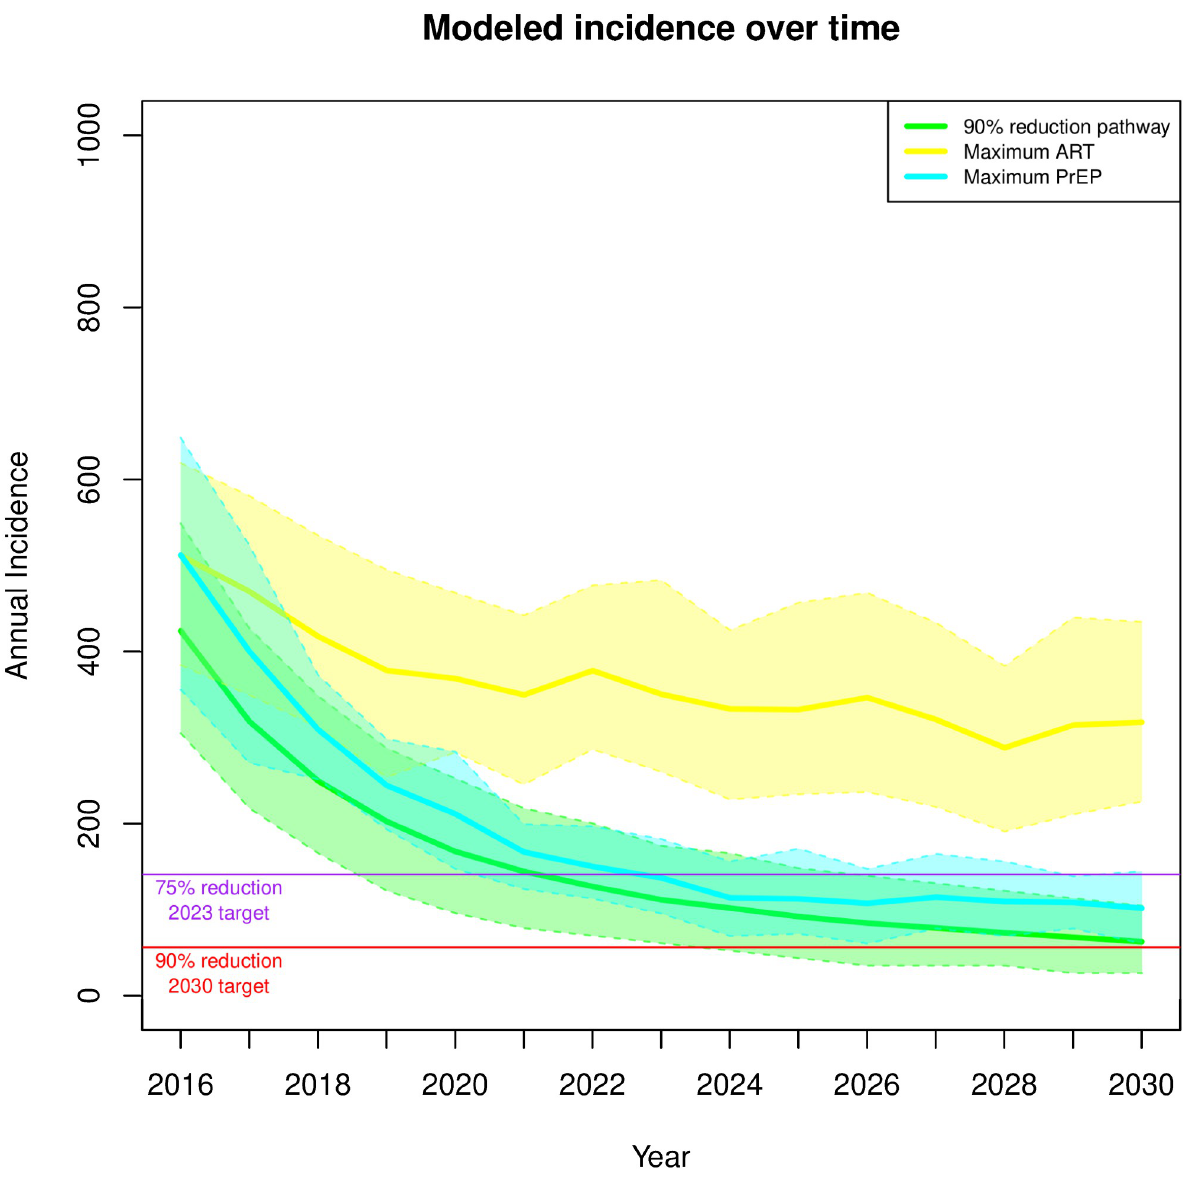
Fig 8. Projected number of incidence cases over time for extreme scenarios: Projected incidence over time for 90% reduction (green); the ART- only scenario that maximizes only ART related levers (yellow); and the PrEP-only scenario that maximizes only PrEP related levers (purple). The solid line represents the mean of each projection; colored surface, the 80% Prediction